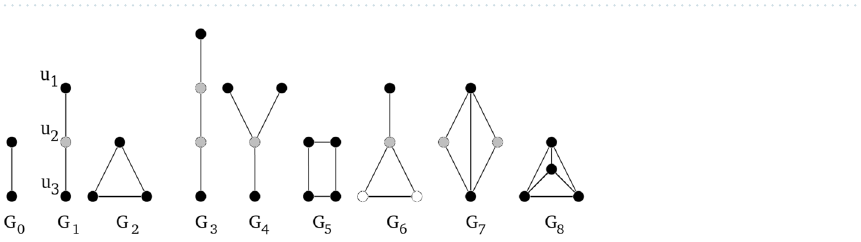
Figure 3. Undirected graphlets with orbits shown in different